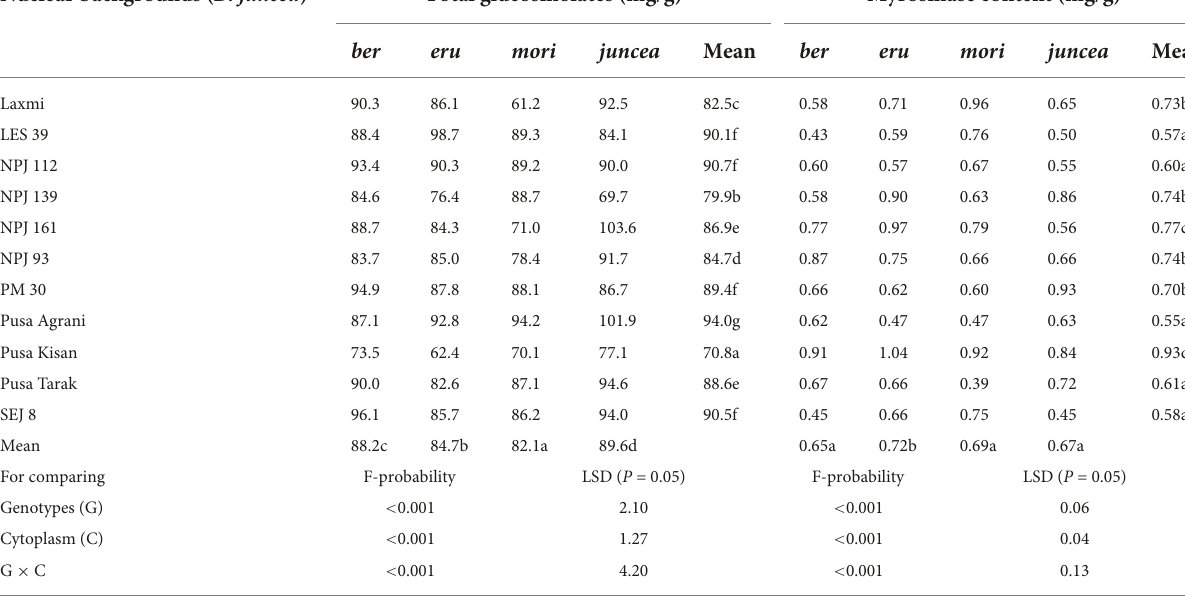
TABLE 4 Effects of cytoplasms and nuclear backgrounds on total glucosinolate and myrosinase contents in auto- and alloplasmic lines of Brassica juncea. Nuclear backgrounds ( B. juncea )